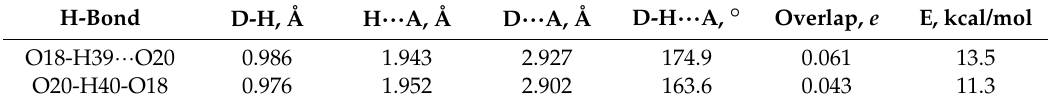
Table 1. Hydrogen bonds in 17 α -dihydroequilin (as calculated by CRYSTAL14).